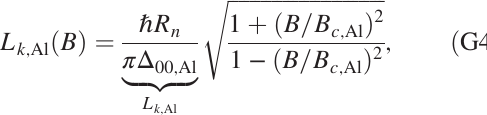
(ii) − 0 . 2 → 0 . 2 mT (green), (iii) 0 . 2 → 0 mT (purple),